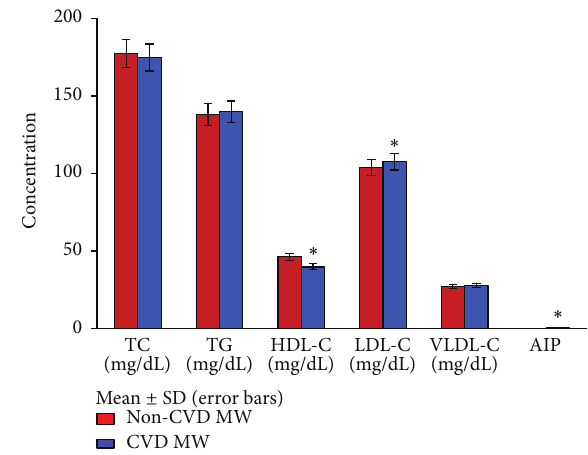
Figure 1: Levels of lipid profile in normolipidemic CVD and non- CVD menopausal women. TC, total cholesterol; TG, triglycerides; HDL-C, high density lipoprotein-cholesterol; LDL-C, low density lipoprotein-cholesterol; VLDL-C, very low density lipoprotein- cholesterol; AIP [log ( TG / HDL-C ) ] is taken as an index of LDL particle size; MW, menopausal women. ∗ 𝑝 < 0.05 significant difference observed in the levels of HDL-C, LDL-C, and AIP between normolipidemic CVD and non-CVD menopausal women. Note . Due to small range of AIP values (mean ± SD), the bars are not visible (AIP value in non-CVD MW is 0.11 ± 0.05 and in CVD MW it is 0.19 ± 0.04).